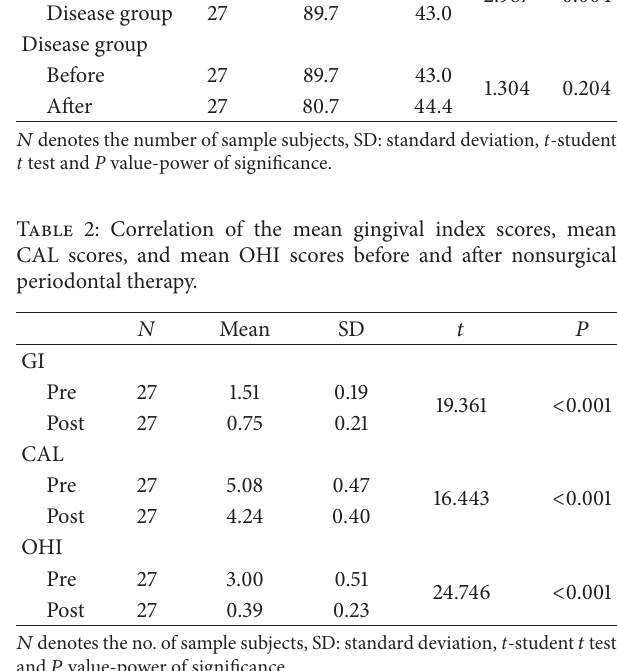
T: Treated subjects; 𝑟 : correlation coefficient; 𝑃 : power of significance.